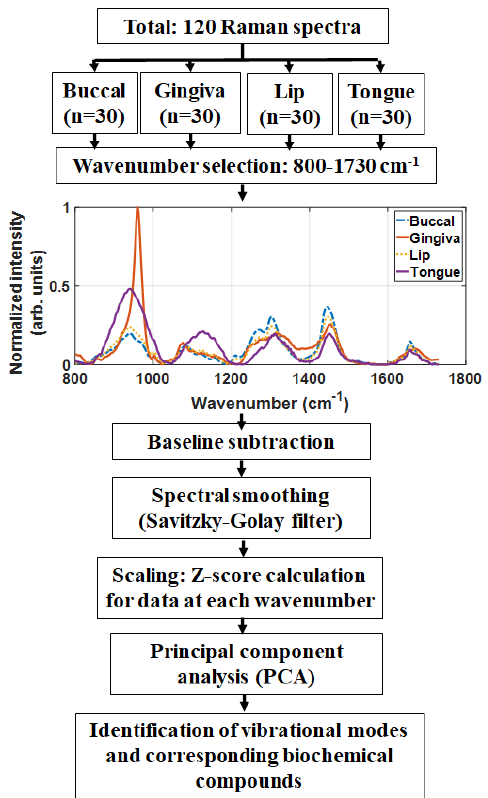
Figure 3. Flowchart of the steps of Raman spectra analysis collected in this study.